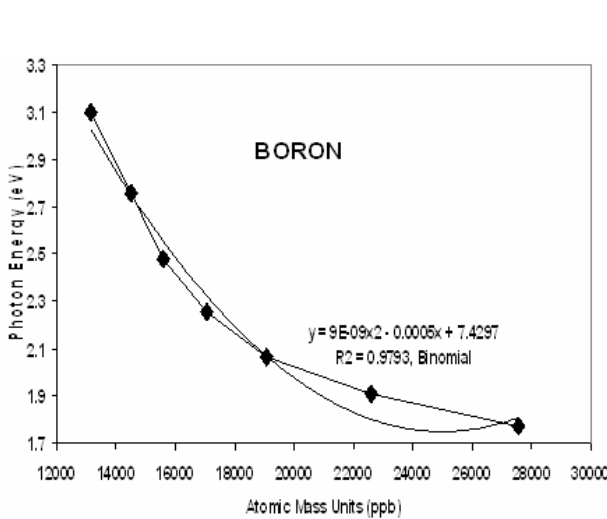
Figure2: Distribution profile of boron leeching from the plastic bottle into the water after exposure to specific photon energy of visible spectrum of light The pH of different E-waters was determined and found to be about 5.5. The addition of sodium bicarbonate to